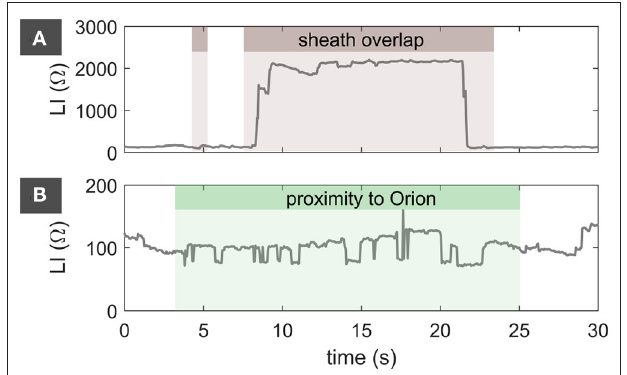
FIGURE 4 | Difference between LI upEn as mapped to the endocardium within the extended mapping region and LI bloodpool combined by anatomical region for all patients. Arranged by ascending median. The virtual LI bloodpool corresponds to 0 (cid:127) . Adjacent distributions which were statistically significantly different are marked with a *. LI, local impedance; sept, septal; ant, anterior; lat, lateral; inf, inferior; post, posterior; RSPV, right superior pulmonary vein; LSPV, left superior pulmonary vein; LIPV, left inferior pulmonary vein; RIPV, right inferior pulmonary